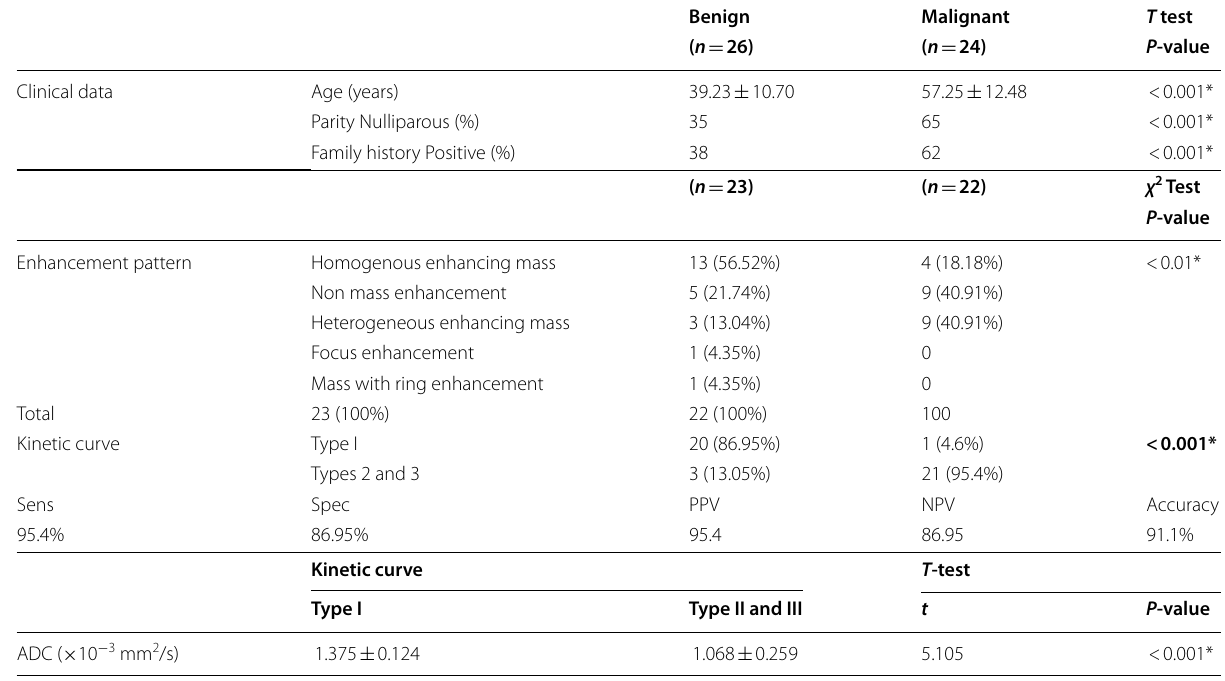
Data are presented as mean SD or frequency (%), *: significant difference at p value < 0.05, ADC: apparent diffusion ±